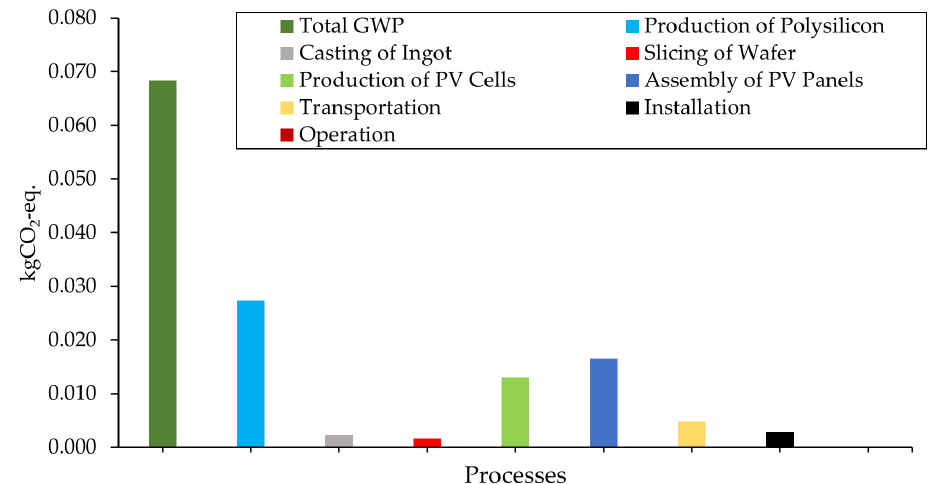
Figure 6. Global warming potential.